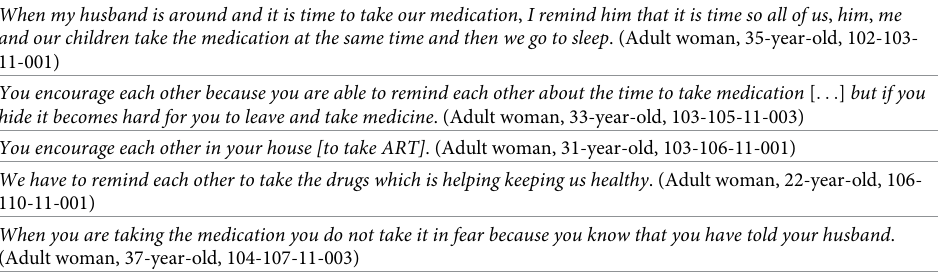
Table 5. Couple support strategies amongst couples who disclosed to each